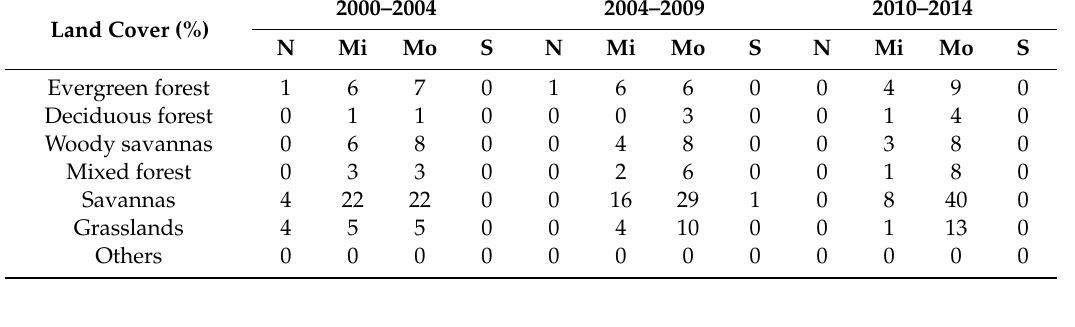
Table 4. Drought intensity of land covers in the Kilombero River catchment. The first, second, and third quinquennia were compared against land covers for the years 2002, 2007, and 2012, respectively. N is no drought condition, Mi is mild drought, Mo is moderate drought, and S is severe drought. Land Cover (%)